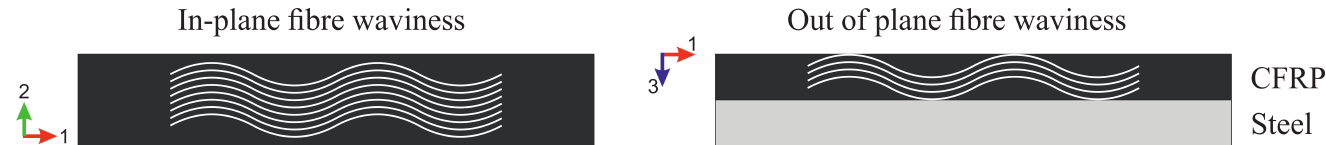
Figure 4. Visualization of the fiber waviness under consideration. Each fiber waviness has been studied independently of each other. Furthermore, the fiber waviness has been assumed to be uniform within the entire